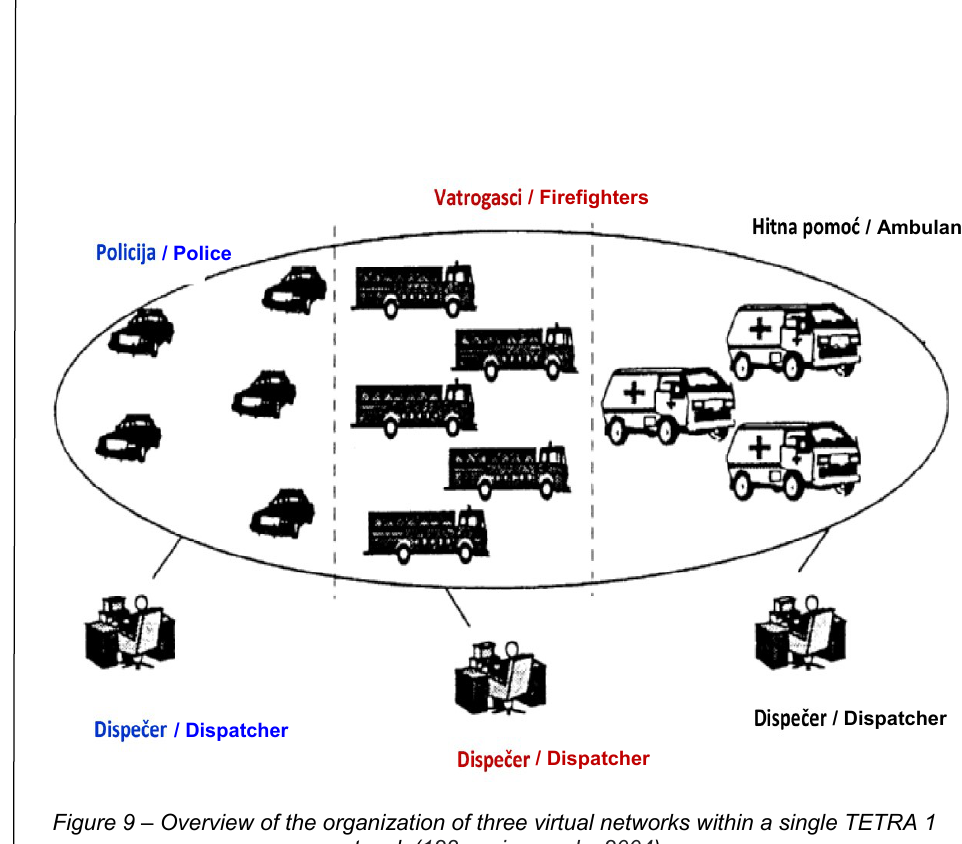
Figure 9 – Overview of the organization of three virtual networks within a single TETRA 1 network (123seminarsonly,